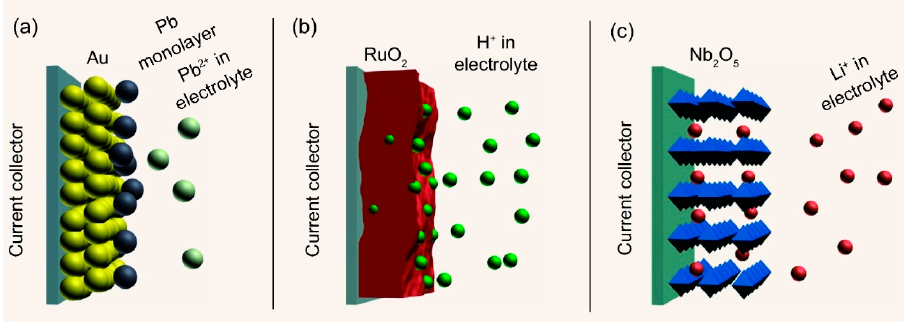
Figure 5. Different types of reversible redox mechanisms that give rise to pseudocapacitance ( a ) under-potential deposition, ( b ) redox pseudocapacitance and ( c ) intercalation pseudocapacitance [24].